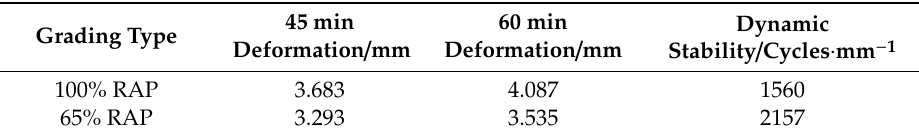
Table 5. Dynamic stability of two gradations.